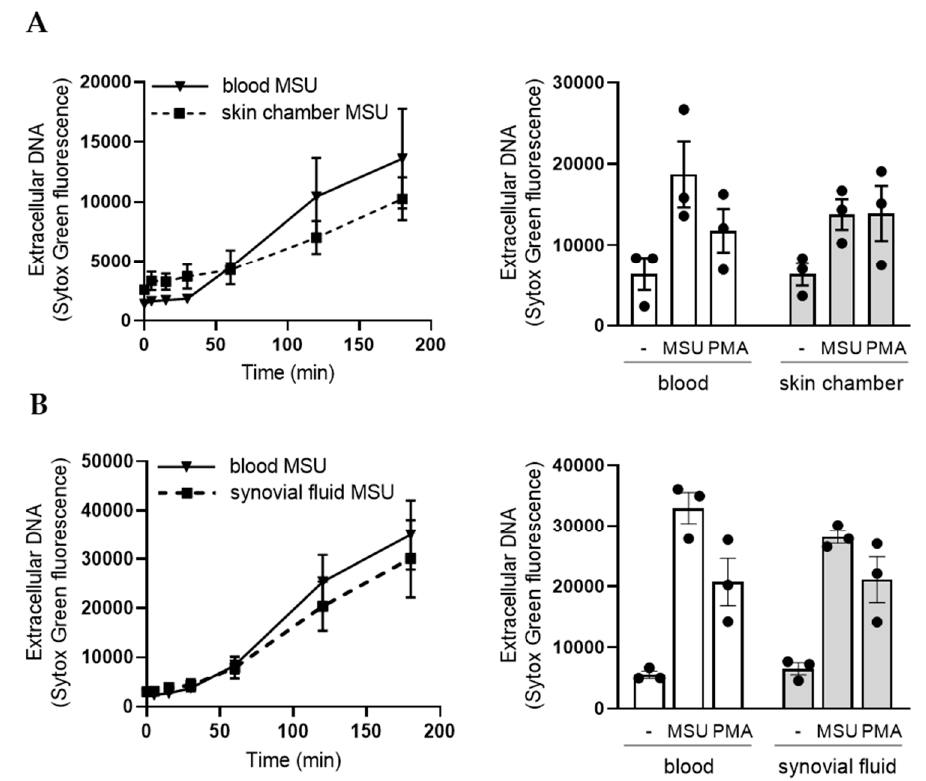
Figure 7. In vivo transmigrated neutrophils are not primed for NET formation. Sytox green fluorescence assay was used to evaluate NET formation of tissue neutrophils from skin chamber fluid ( A ) or synovial fluid ( B ) after stimulation with MSU crystals (300 µ g / mL). Tissue neutrophils (broken lines) formed NETs in a similar manner as blood neutrophils (solid lines) from the same donor assayed in parallel. Shown are representative curves for skin chamber neutrophils ( A ), and synovial fluid neutrophils ( B ), and the mean fluorescence values +/ − SEM at 3 h from three independent experiments of each type of tissue neutrophils.